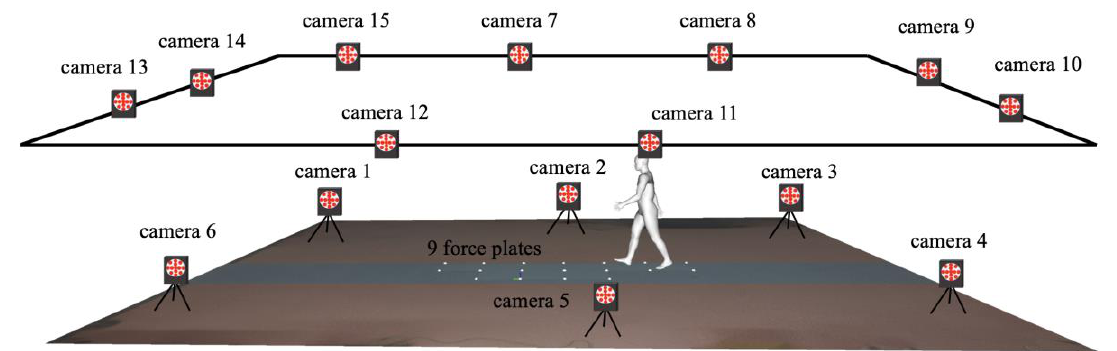
Figure 2. Schematic diagram of a subject during walking and recording of kinematic and kinetic data using a 15-camera motion capture system and nine force plates.